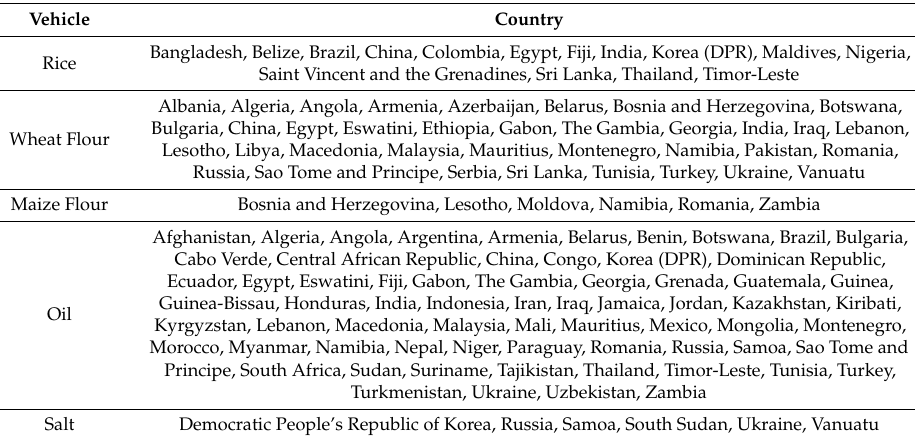
Figure 2. Low-income, middle-income, and upper-middle income countries that do not have mandatory programs in place and have the potential to benefit from new LSFF programs or making voluntary programs mandatory. Table 1. Low-income, middle-income, and upper-middle income countries that have potential to benefit from new LSFF programs or making voluntary programs mandatory.